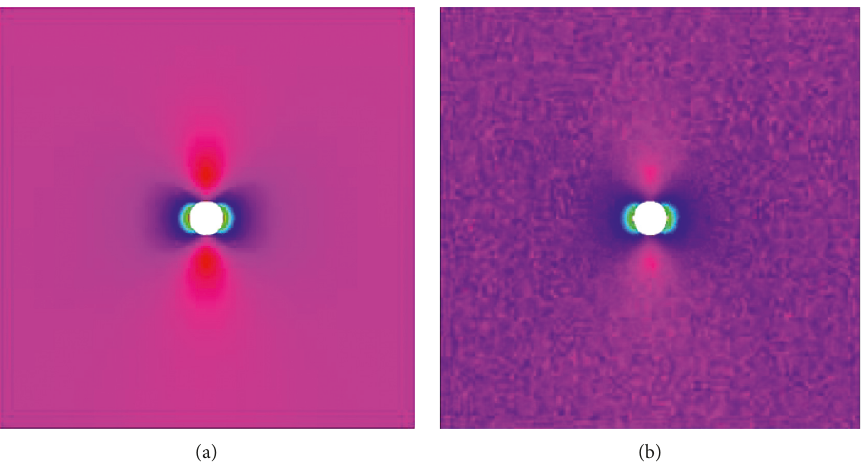
Figure 8: Distribution diagram of the first principal stress. (a) m